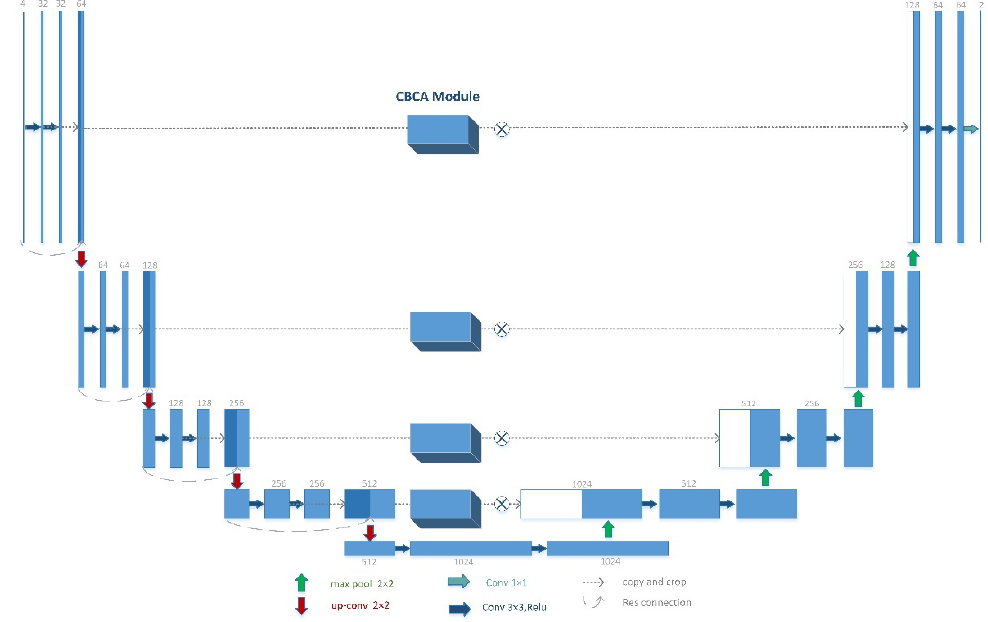
Figure 6. The structure of the concatenated residual attention UNet.